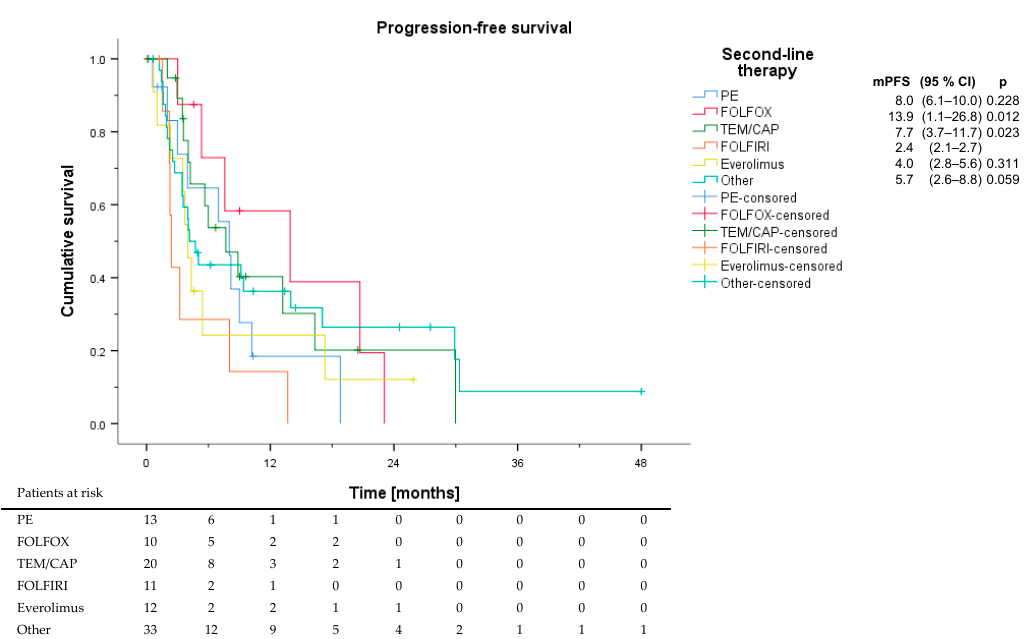
Figure 3. Progression-free survival of different second-line regimens. Patients receiving PRRT, SSAs, targeted agents, checkpoint inhibitors, and other chemotherapy regimens like STZ/5-FU and topotecan were subsumed under other. All p values are delineated in comparison to